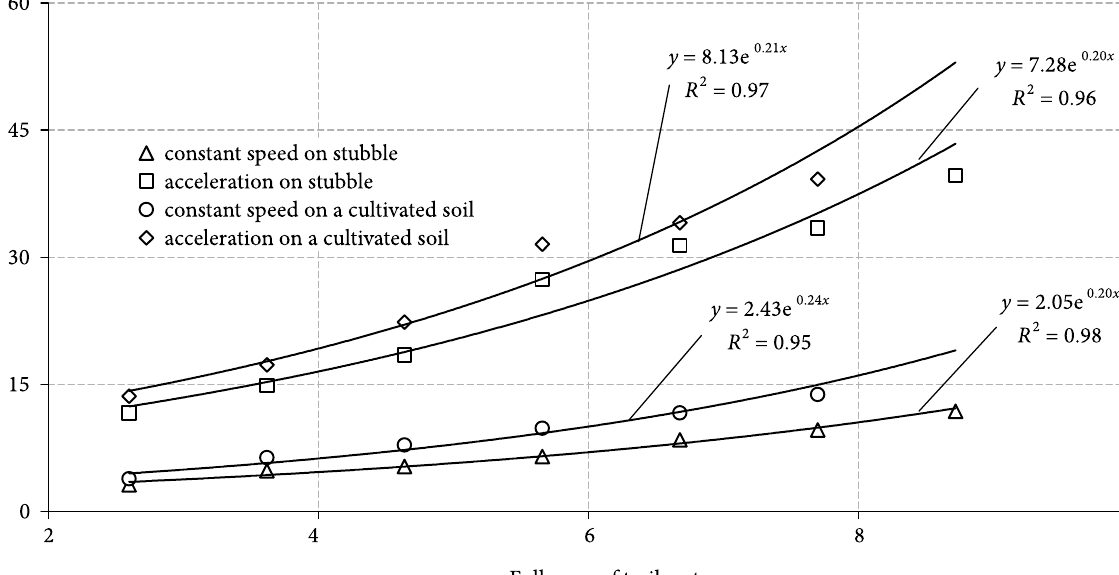
Fig. 2. The dependence of wheel slippage on the full mass of the